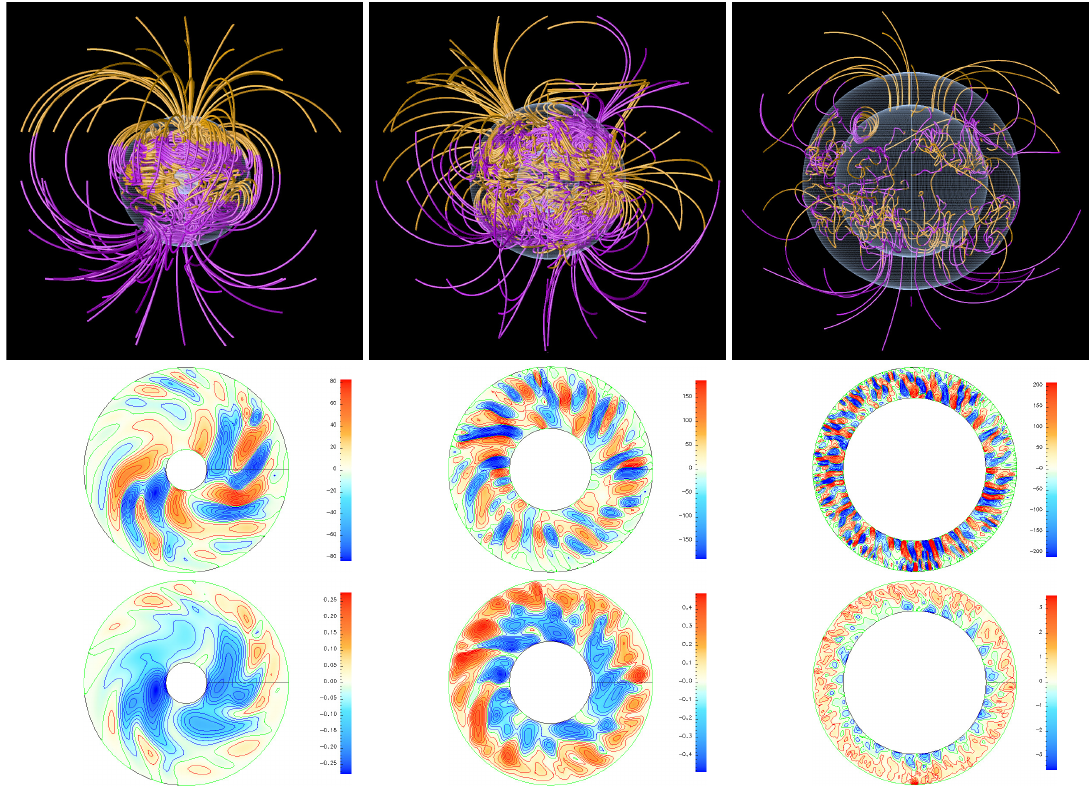
Figure 4. Snapshots of spatial structures of dynamo solutions with increasing shell thickness aspect ratio η and with R = 3.8 10 4 , P = 0.75 and P m = 1.5. Three cases are shown as follows: R c , τ = 2 × × η = 0.2, R = 4,000,000 (left column); η = 0.4, R = 1,500,000 (middle column); and η = 0.7, R = 180,000 (right column). Magnetic poloidal fieldlines are plotted in the top row, contours of the radial velocity u r in the equatorial plane are plotted in the middle row, and contours of the temperature perturbation Θ in the equatorial plane are plotted in the bottom row. (Colour